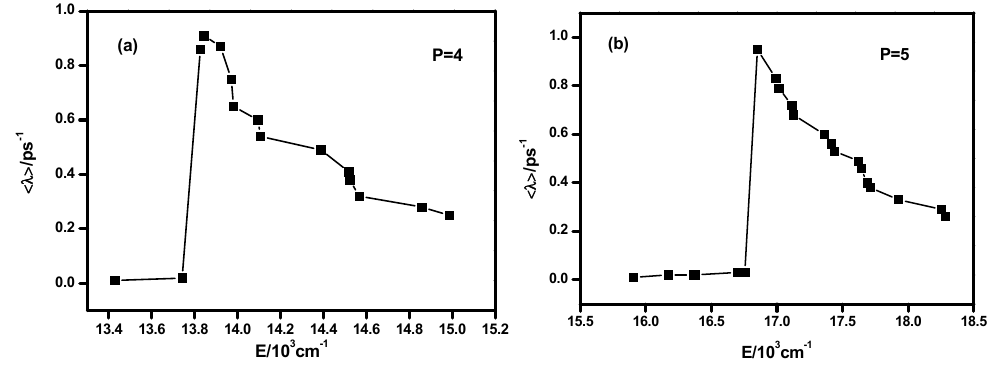
Figure 7. Lyapunov exponent of every highly excited vibrational state when ( a ) P = 4 and ( b ) P = 5.